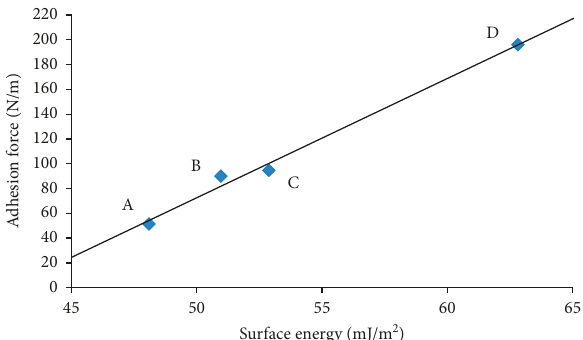
Figure 5: Adhesion force of the polyethylene as a function of the surface energy of the top of the paperboard coated with (A) nonpolar latex without flame treatment, (B) nonpolar latex with flame treatment, (C) polar latex without flame treatment, and (D) polar latex with flame treatment.